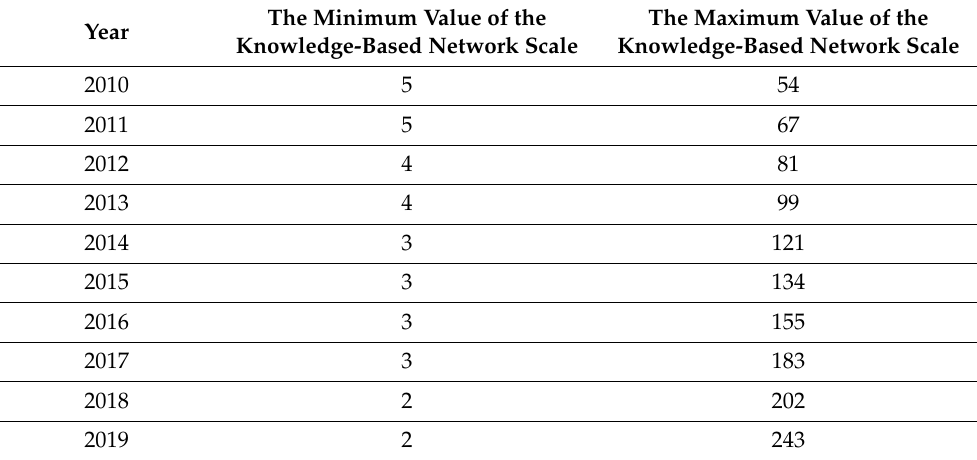
Table 1. The maximum and minimum values of the knowledge-based network scale. Year The Minimum Value of the Knowledge- The Maximum Value of the Knowledge-Based Network Scale